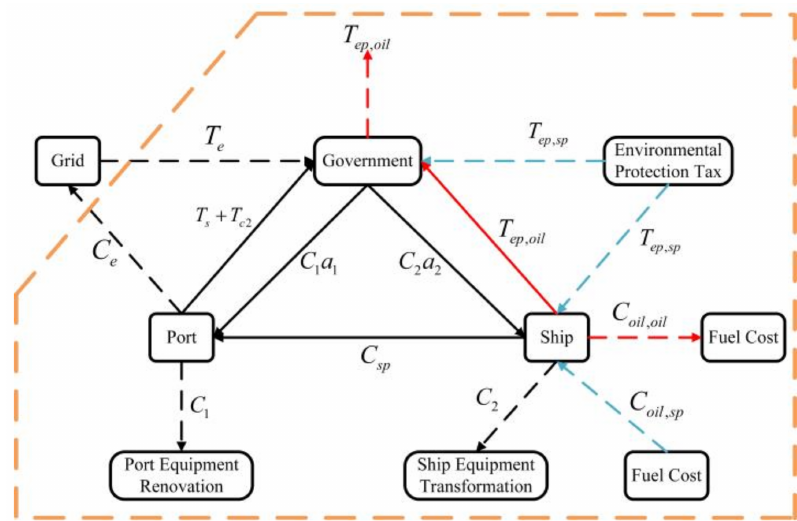
Figure 3. Tripartite benefit analysis under carbon tax